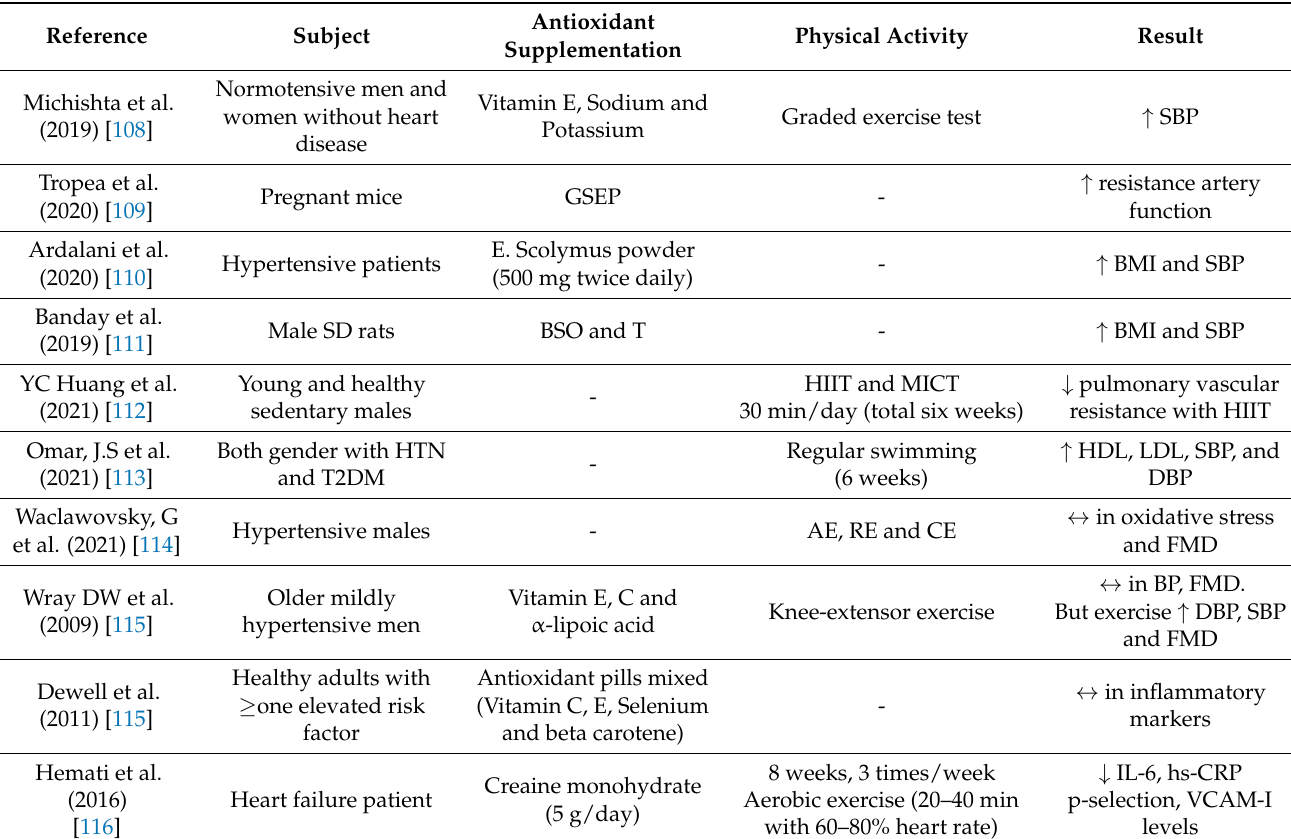
Table 1. Antioxidant and physical activity